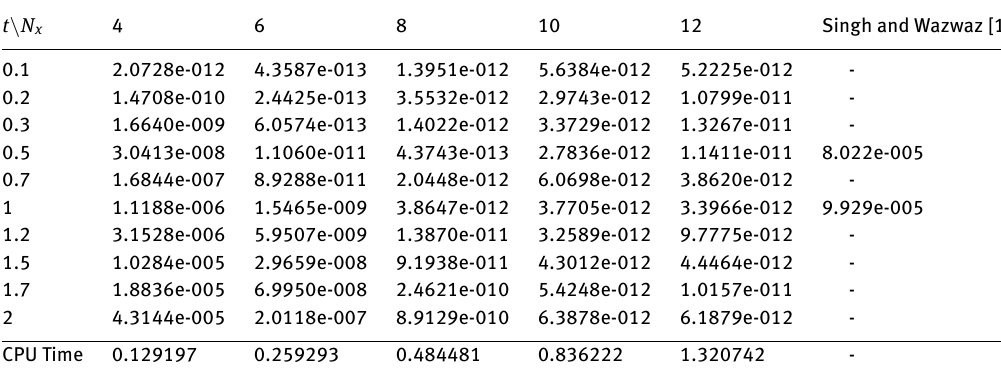
Table 6: Maximum errors E N for example 4 using N t = 10, m = s = 3 and k = p =